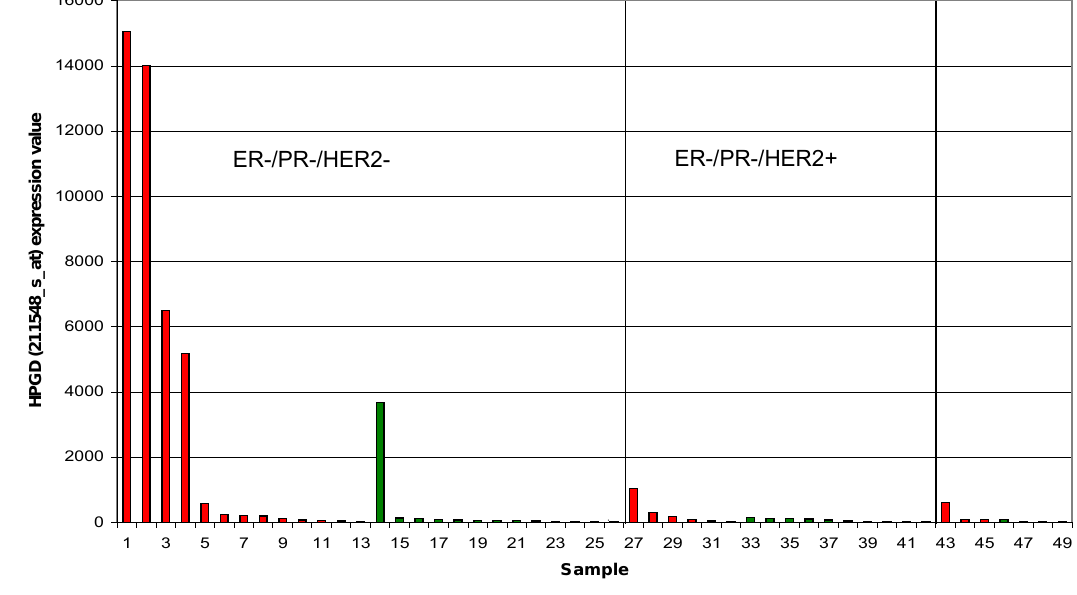
Figure 2: Gene expression values of HPGD (211548_s_at) in ER-negative patients. This graph partitions the ER- patients into three subgroups: ER-/PR-/HER2-, ER-/PR-/HER2+ and the rest. Non-pCR samples are shown in red bars and pCR samples are shown in green